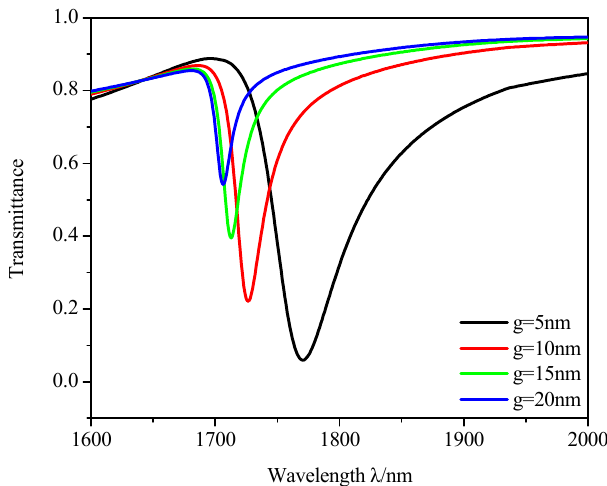
Figure 10. Transmission spectra of different coupling distances g.